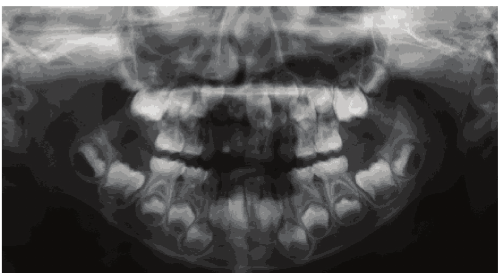
Figure 5: Panoramic radiograph at first visit (case 2). The perma- nent maxillary right central and lateral incisors are malformed and hypocalcified.